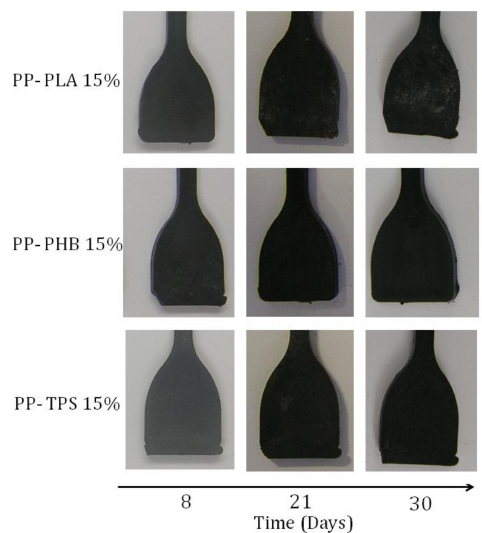
Figure 9. Visual appearance of recovered blend samples at different times of composting (8, 21 and 30